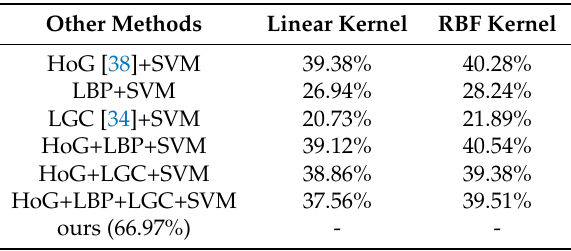
Table 10. Comparison with several traditional classic operators on the RAF Compound test